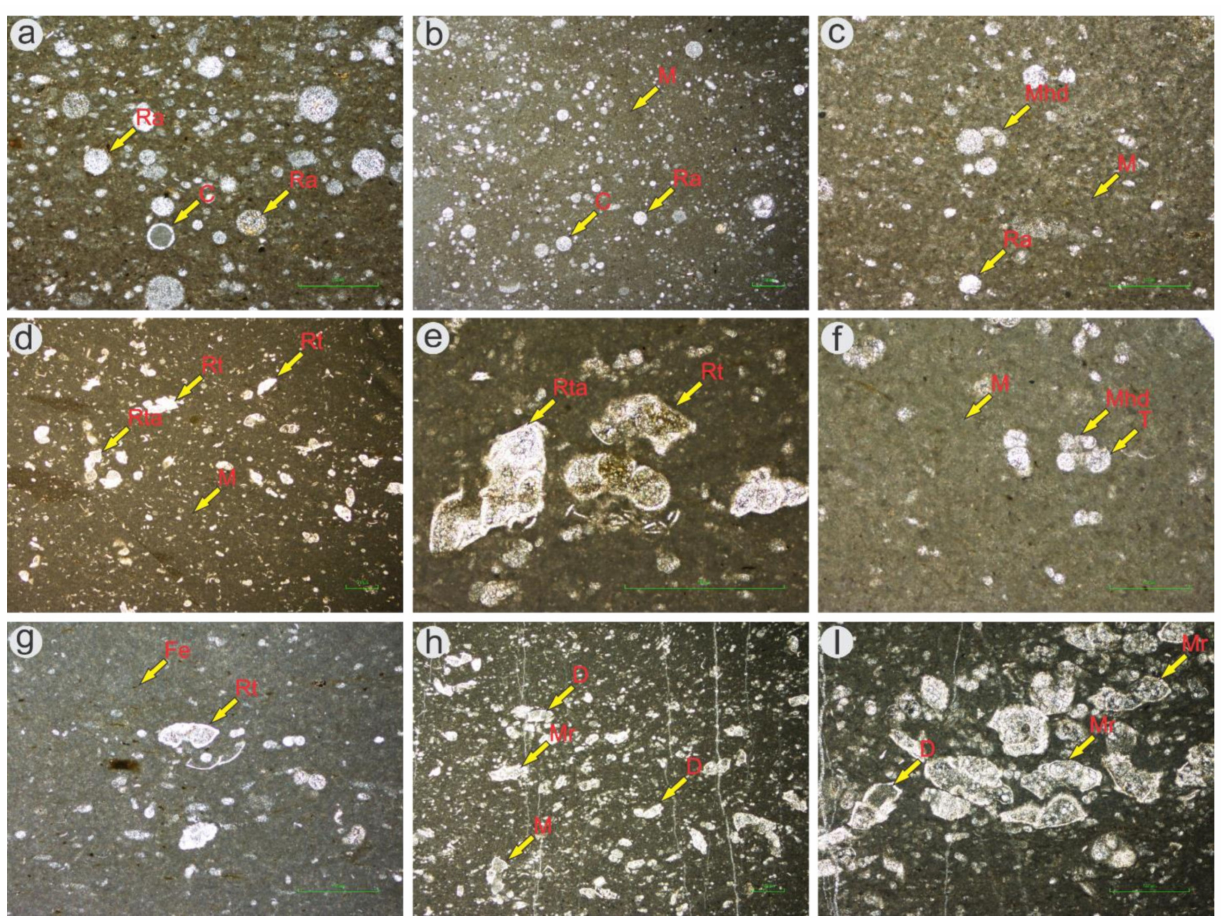
Figure 5. ( a ) Photomicrograph of the Radiolarians rich wacke-packestone microfacies (MF-1) showing radiolarians (Ra) and Calcisphere (C); ( b ) Photomicrograph of the MF-1 (zoomed view) showing matrix (M), radiolarians (Ra) and Calcisphere (C); ( c ) Photomicrograph of the Radiolarians rich wackestone microfacies (MF-2) showing radiolarians (Ra), matrix (M) and muricohedbergella (Mhd); ( d ) Photomicrograph of the Planktonic foraminiferal wacke-packestone microfacies (MF-3) showing rotalipora sp. (Rt), rotalipora appenninica (Rta), and matrix (M); ( e ) Photomicrograph of the MF-3 (zoomed view) showing Rotalipora appenninica (Rta), and rotalipora sp. (Rt); ( f ) Photomicrograph of the Planktonic foraminiferal wackestone microfacies (MF-4) having muricohedbergella (Mhd), Ticinella (T) and matrix (M); ( g ) Photomicrograph of the MF-4 (zoomed view) having iron filaments (Fe) and rotalipora (Rt); ( h ) Photomicrograph of the Planktonic Foraminiferal Packestone Microfacies (MF-5) showing marginotruncana (M) and dicarinella (D); ( i ) Photomicrograph of the MF-5 (zoomed view) having dicarinella (D); and marginotruncana